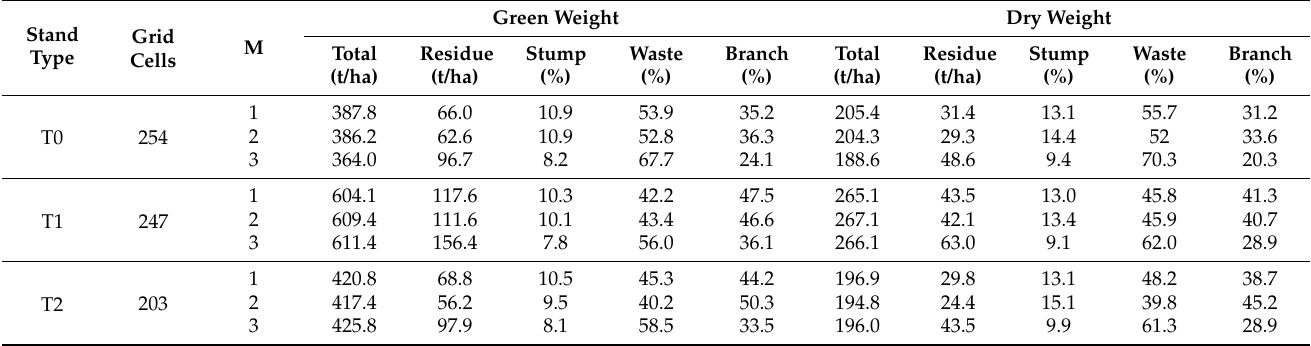
Figure 9. Heatmaps of waste biomass in green weight for three harvested areas representing T0, T1, and T2 plantations ( Left ). Grid cell maps of total harvest residue biomass in green weight and its proportional allocation to the three residue components ( Right ). The biomass quantities were cal- culated using the third method through harvester data analytics.